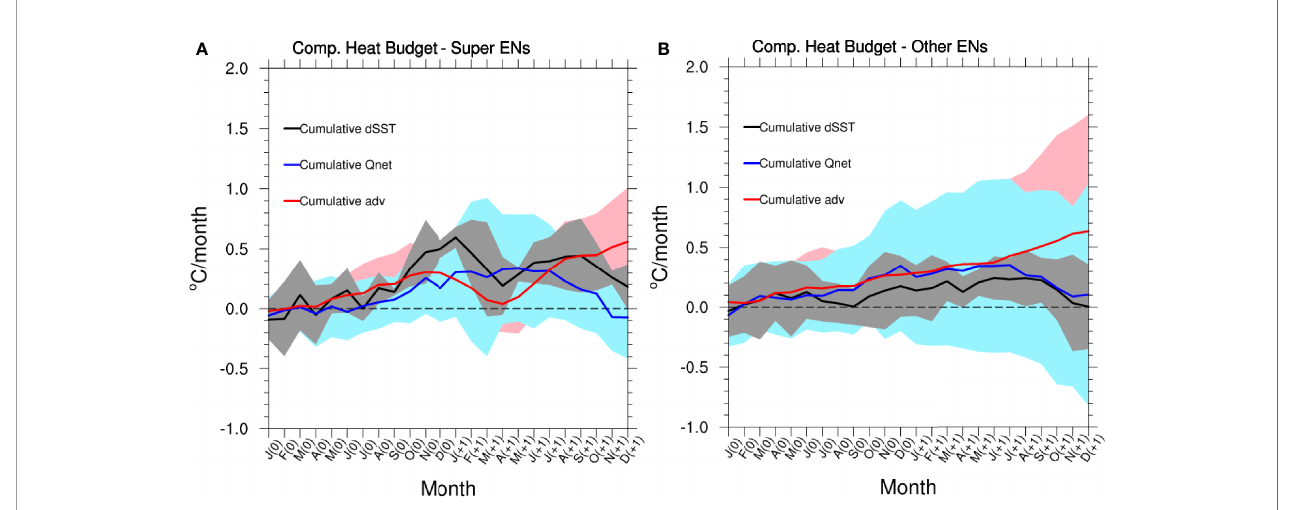
FIGURE 4 | (A) Mixed layer heat budget results averaged over the SCS for super El Niño composite. The black line is the cumulative mixed layer temperature tendency (dSST), and the blue and red lines indicate the cumulative net surface heat fl ux (Qnet) and three-dimensional advections (adv), respectively. Shading indicates ±1 standard deviations of every month. (B) Same as in (A) but for other El Niño